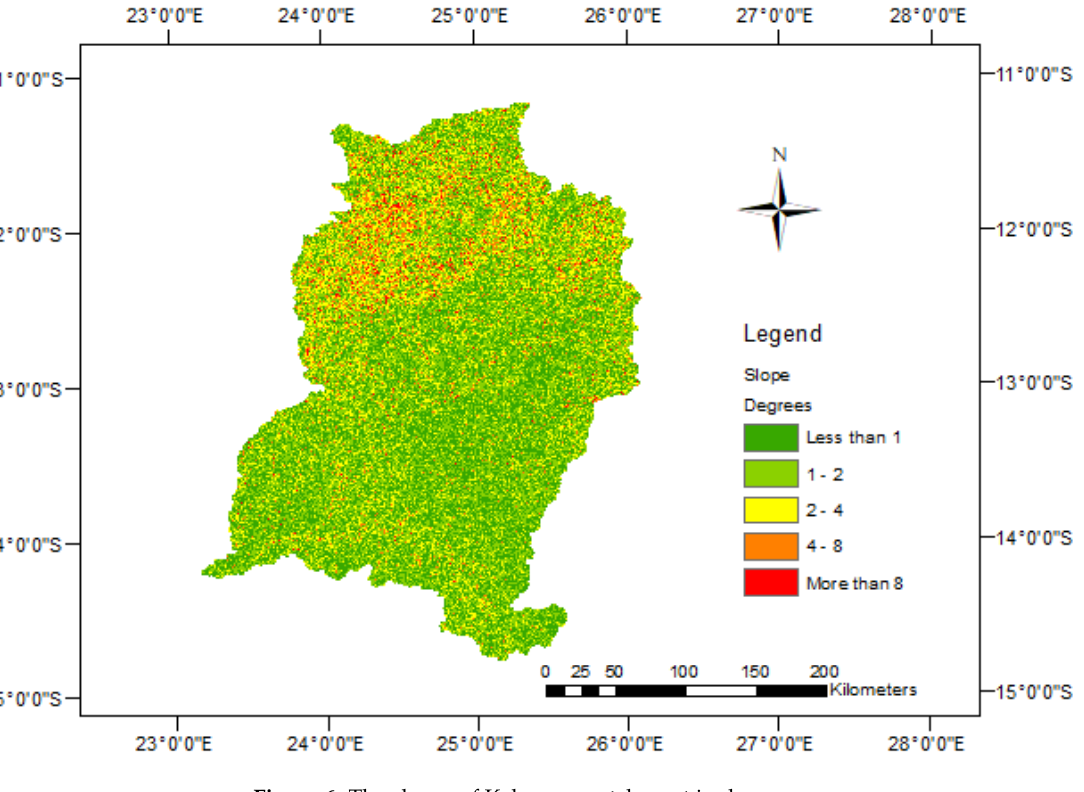
Figure 6. The slopes of Kabompo catchment in degrees.